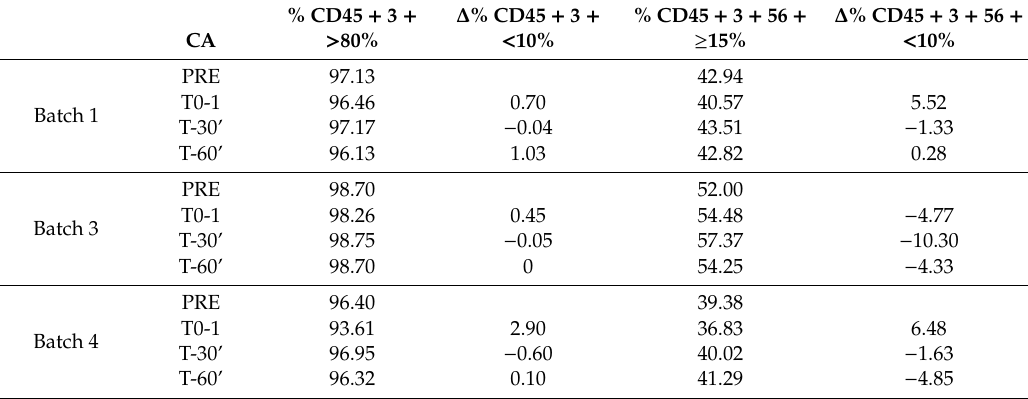
Figure 2. Viability on Batches 1, 3 and 4 evaluated for their validation of the cryopreservation and transportation processes before freezing. The percentage of viable cells was calculated on fresh product at the time of pre-freezing (PRE) and at different time periods after adding the freezing solution containing DMSO: immediately (T0), after 30 min (T-30′) and after 60 min (T-60′). Table 1. Identity evaluated by immunophenotype analysis on Batches 1, 3 and 4. The values and relative Δ, in percentages, were evaluated between the immunophenotype of the post-thawing conditions and referred to as T0-1 (T0), T-30′ and T-60′ vs. pre-freezing conditions, referred to as PRE. CA = Acceptance criteria, the limits of which are indicated in bold, are reported. ND = condition not determined.